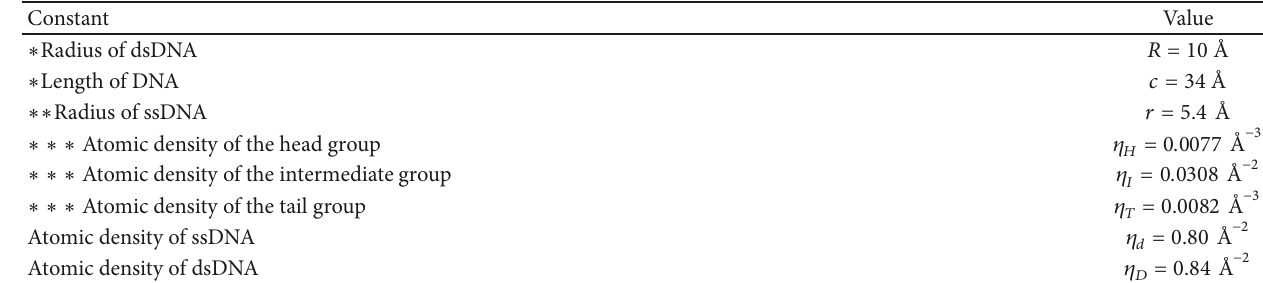
Table 1: Numerical values for constants used in this paper ( ∗ denotes data from [21], ∗∗ denotes data from [22], and ∗∗∗ denotes data from [18]).